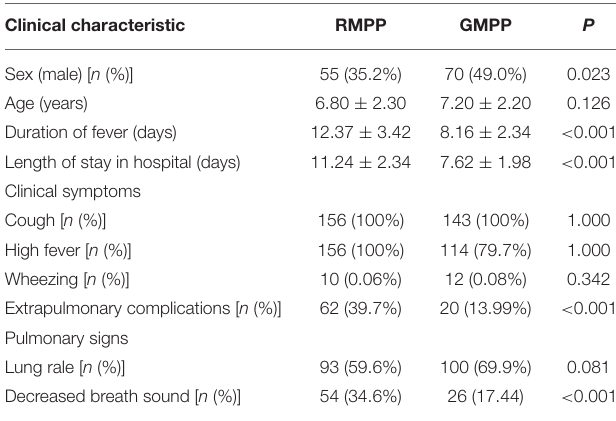
TABLE 1 | Clinical characteristics of GMPP and RMPP patients.